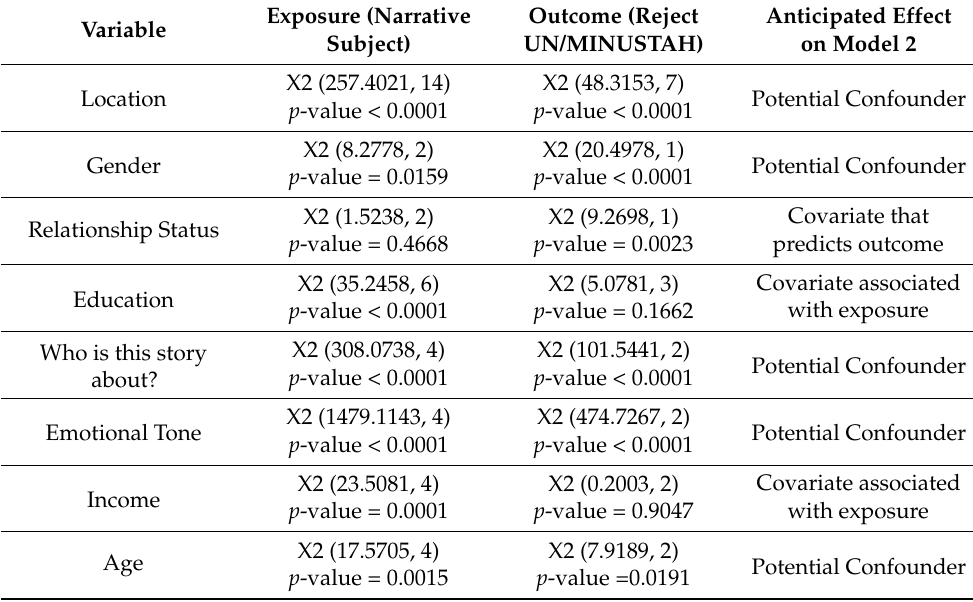
Table A2. Bivariate Analyses Objective 2.